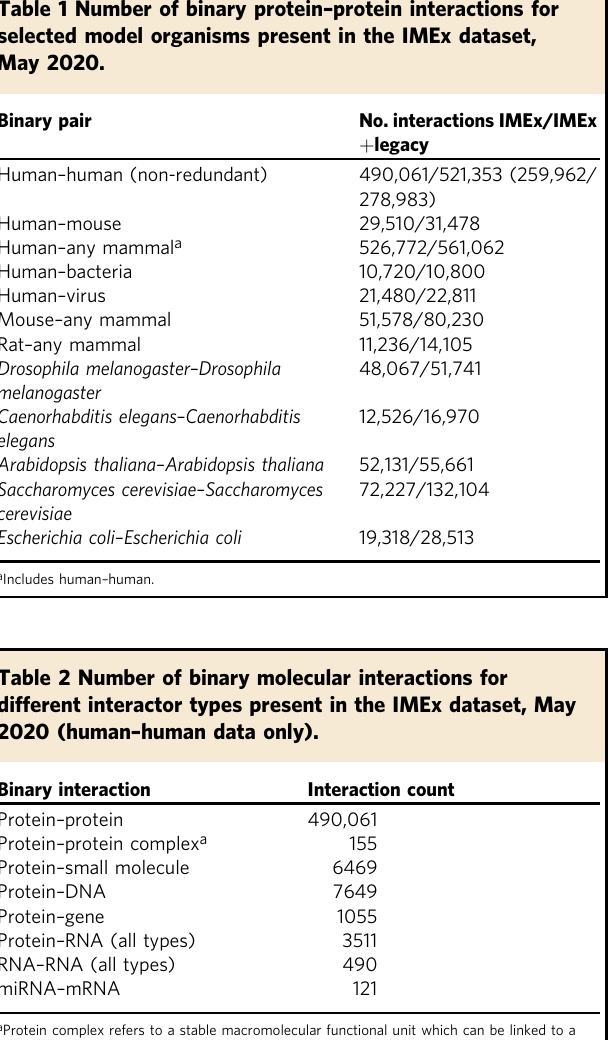
Table 1 Number of binary protein – protein interactions for selected model organisms present in the IMEx